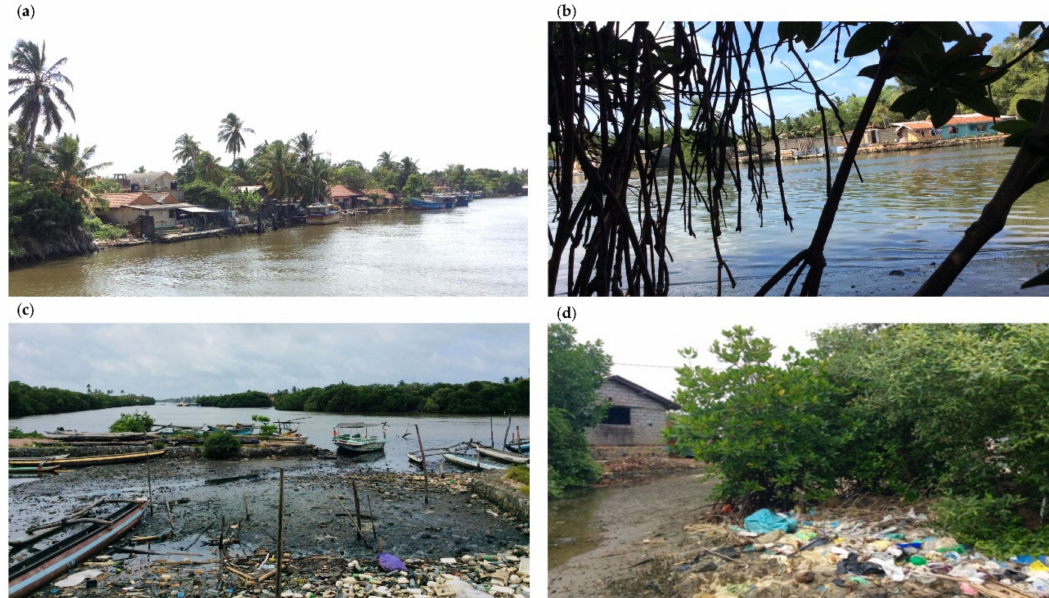
Figure 9. Some fieldwork photos of the MMNL: ( a ) Human encroachment in Negombo Lagoon area, ( b ) Illegal settlements of the study area, ( c ) Dumping of garbage into the lagoon, and ( d ) Human activities inside the Muthurajawela marshland. Source: First author (D. A.),